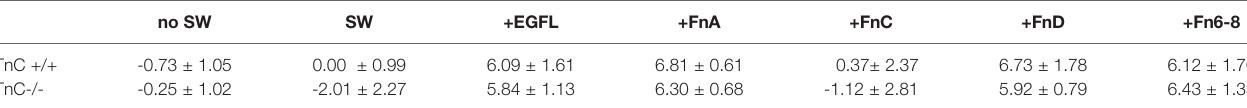
TABLE 5 | Mean values ± standard deviations of proin fl ammatory cytokine IL-1 b levels in astrocyte cultures.